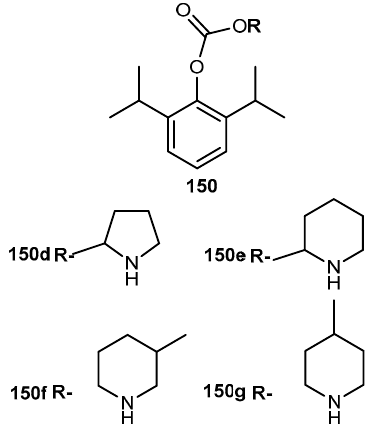
Figure 64. Cyclic amino acid derivates of propofol synthesized by Altomare et al. [201].